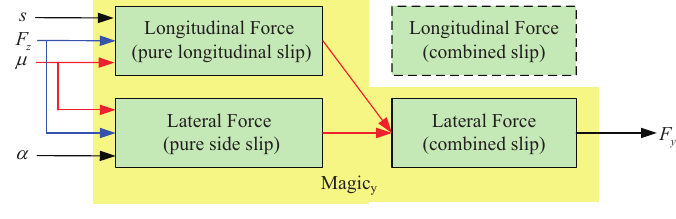
Figure 6. Structure of the Magic